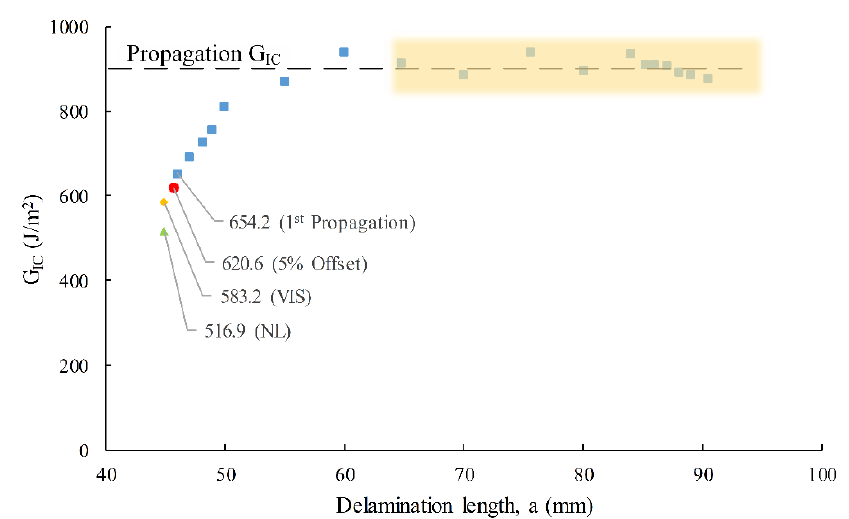
Figure 10. Crack Resistance Curve (R-Curve) of a typical UD-FFREC DCB, the plateau region is highlighted.